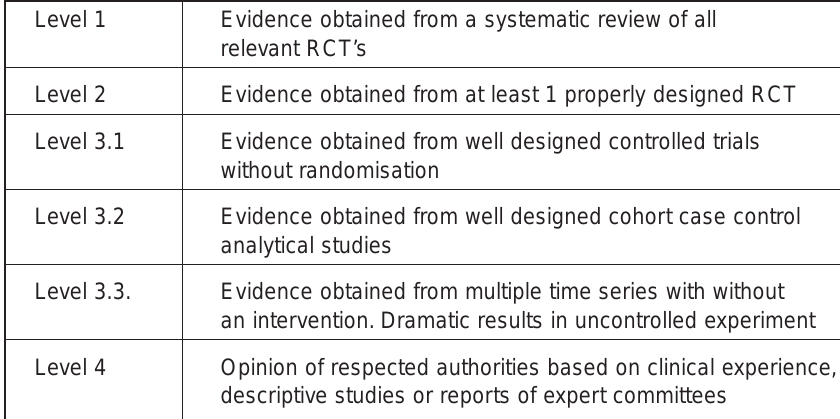
Table 1: JBI scale of level of evidence: